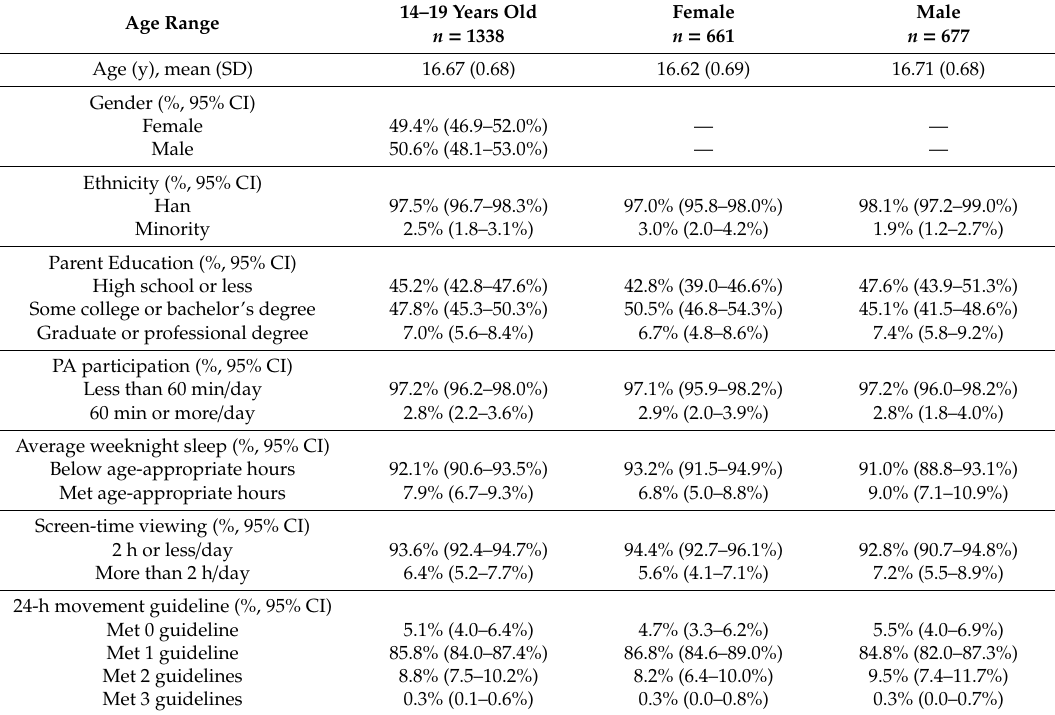
Table 1. Demographic characteristics of adolescents in high